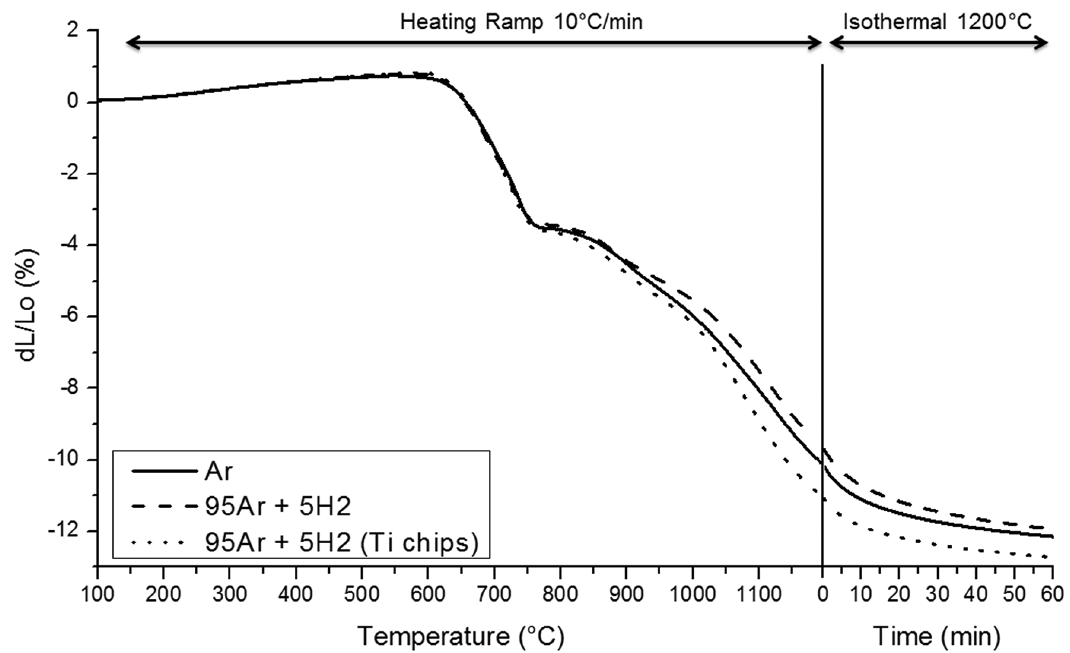
Figure 5. Hadfield steel samples sintered under different conditions of gas atmosphere. Author: Renan Schroeder.